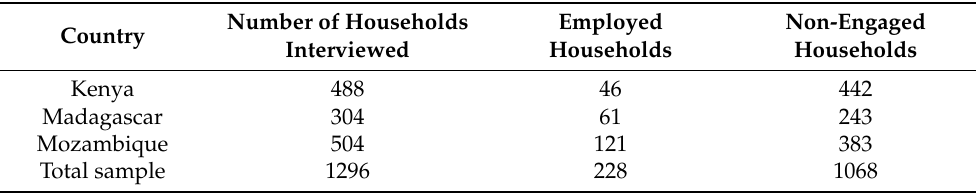
Table 2. Sample size.